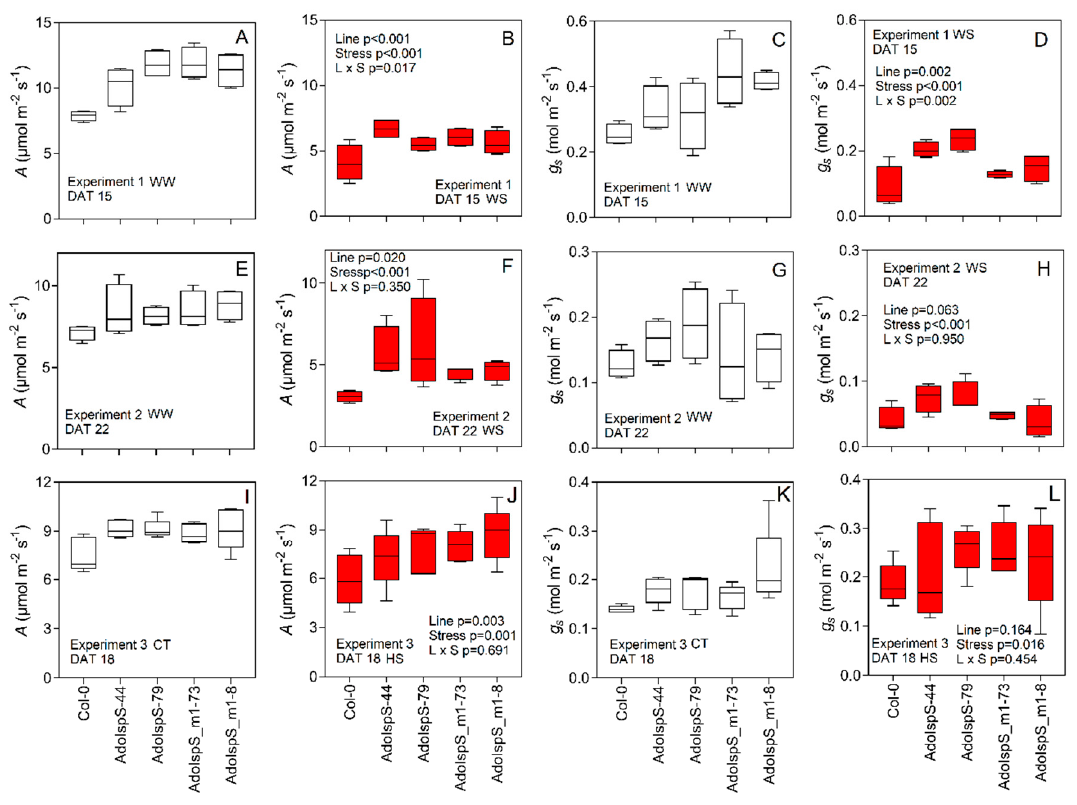
Figure 6. CO 2 assimilation rate ( A ) and stomatal conductance ( g s ) collected in Experiment 1 ( A, B, C, D ), Experiment 2 ( E, F, G, H ), and Experiment 3 ( I, J, K, L ). The two-way ANOVA output is shown in each graph. Measurements (n = 4 to 5) were performed at 600 μ mol m − 2 s − 1 PAR, 23 °C leaf temperature, and 400 μ mol mol − 1 [CO 2 ] in Experiment 1 and 2 (water stress experiments) while in